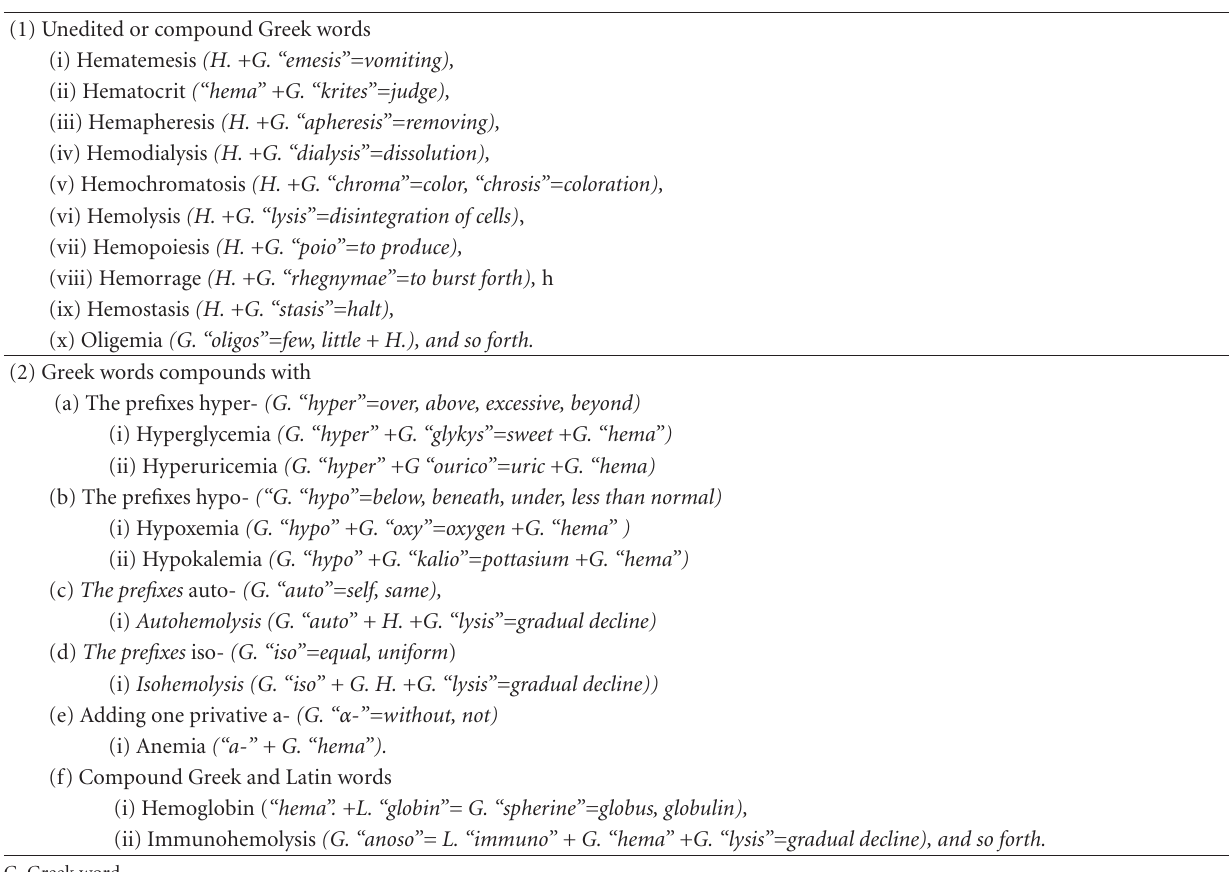
Table 1: Examples of words in the english dictionary containing the greek word “hema” and its